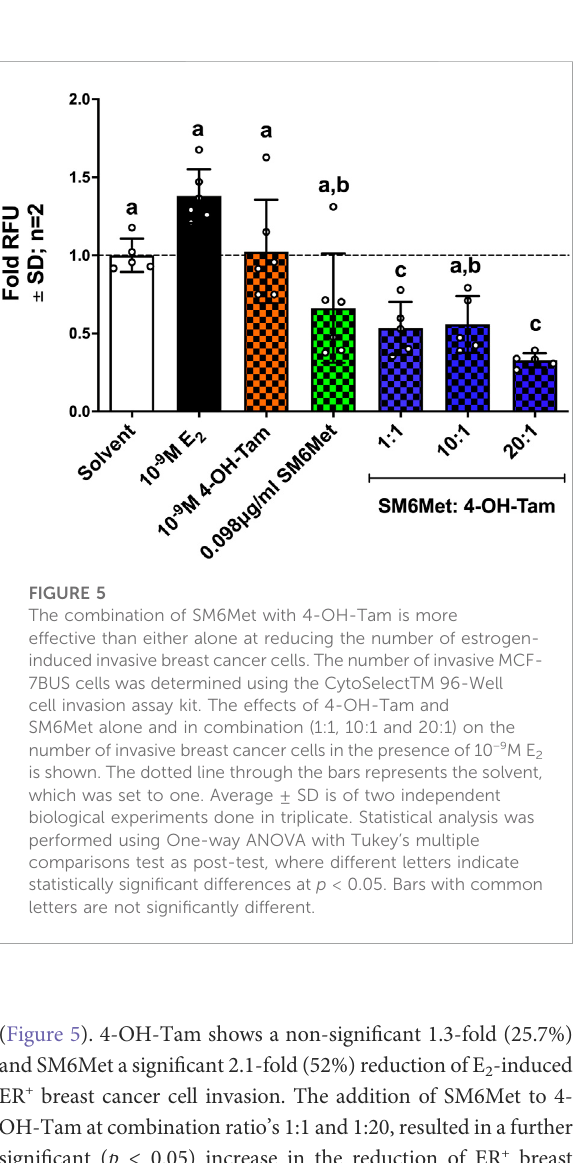
(Figure 5). 4-OH-Tam shows a non-signi fi cant 1.3-fold (25.7%) and SM6Met a signi fi cant 2.1-fold (52%) reduction of E 2 -induced ER + breast cancer cell invasion. The addition of SM6Met to 4- OH-Tam at combination ratio ’ s 1:1 and 1:20, resulted in a further signi fi cant ( p < 0.05) increase in the reduction of ER + breast cancer cell invasion as compared to 4-OH-Tam or SM6Met alone, with the highest inhibition elicited by the 20: 1 combination ratio.